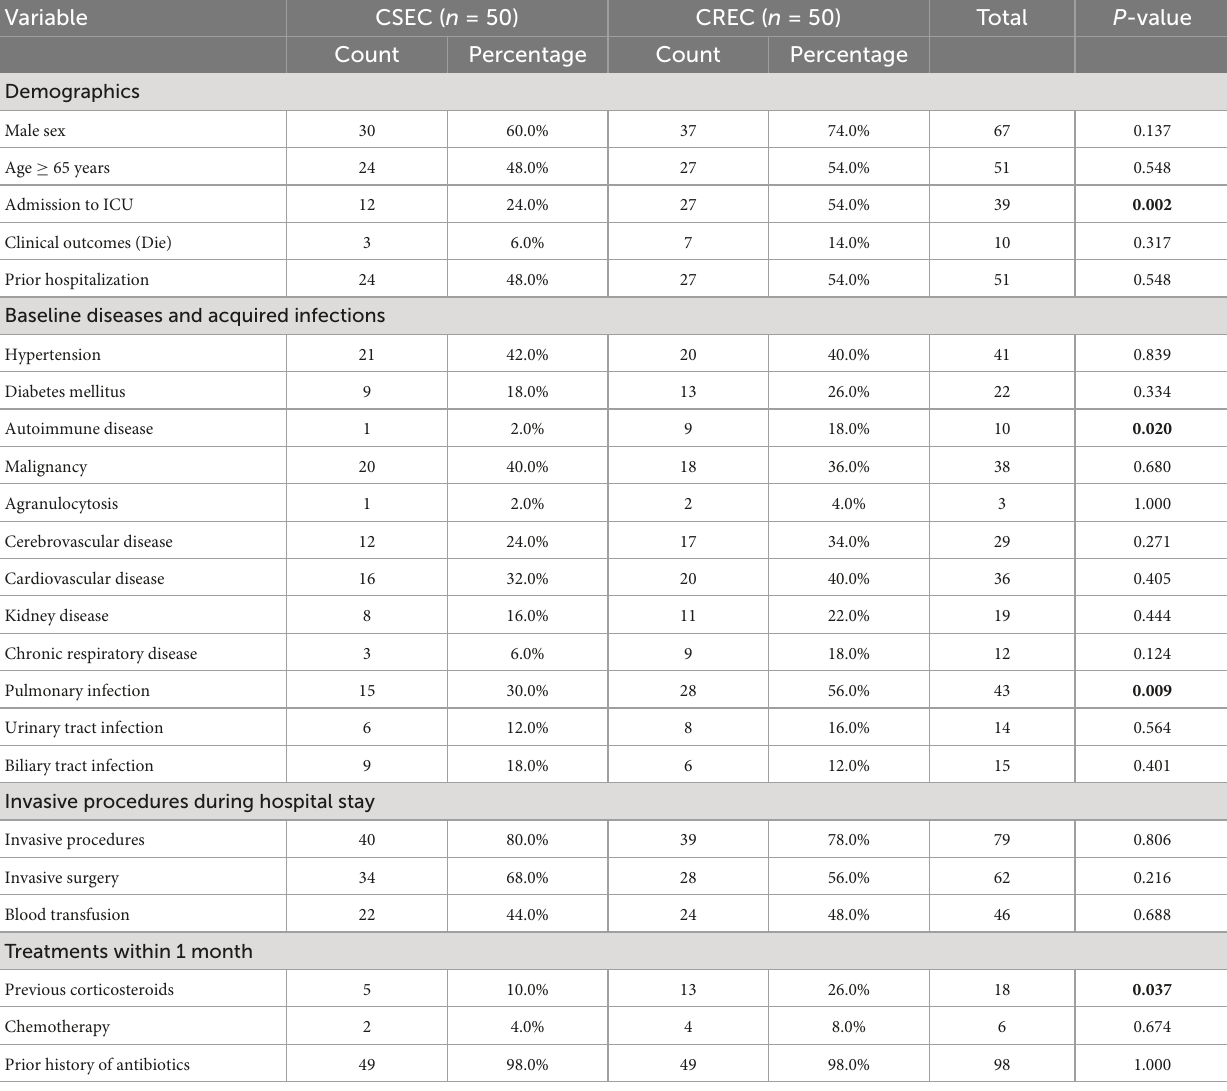
TABLE 2 Univariate analysis of the risk factors for acquiring carbapenem-susceptible Enterobacter cloacae complex (CSEC) and carbapenem-resistant Enterobacter cloacae complex (CREC). Variable CSEC ( n = 50)